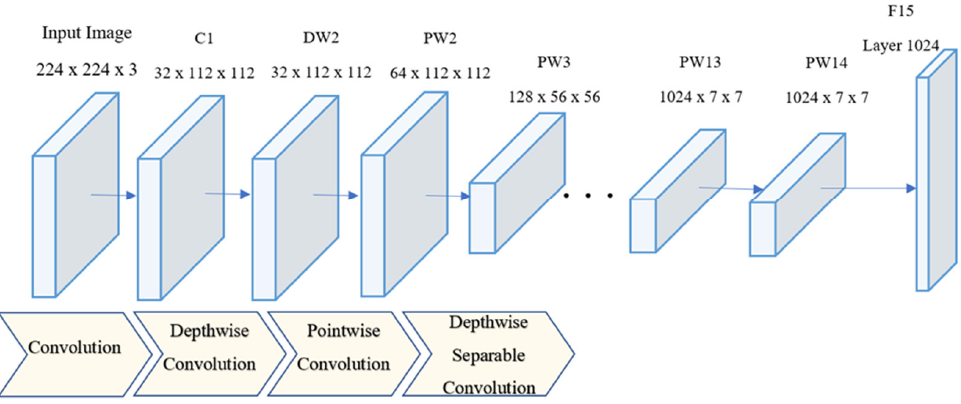
Figure 2. MobileNet